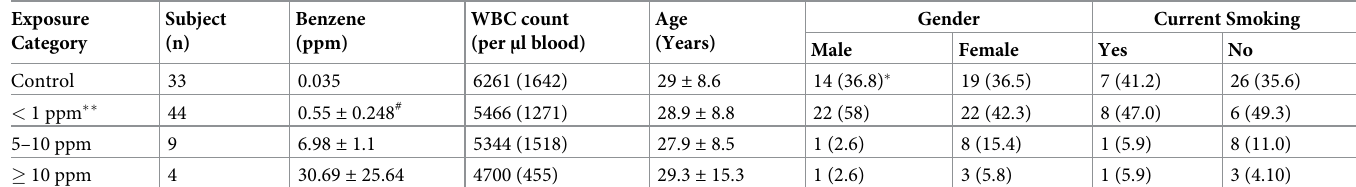
Table 1. Characteristics of study